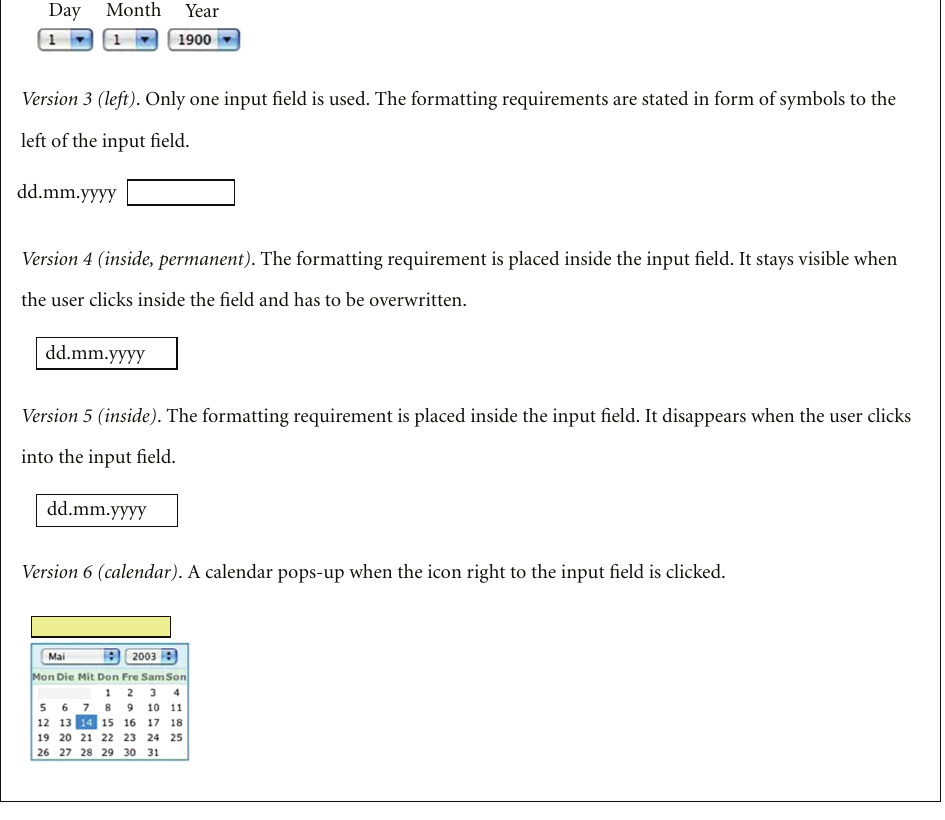
Figure 1: Design versions used as independent variables: input types for date entries (translated by the